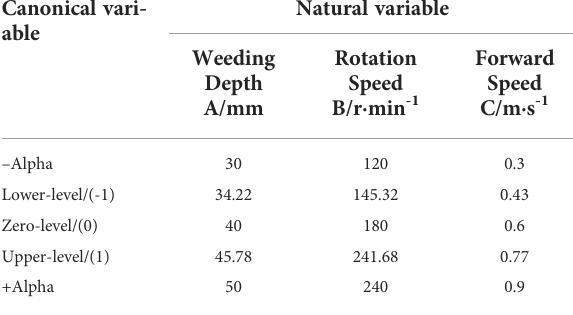
TABLE 2 Coding with factors and levels.